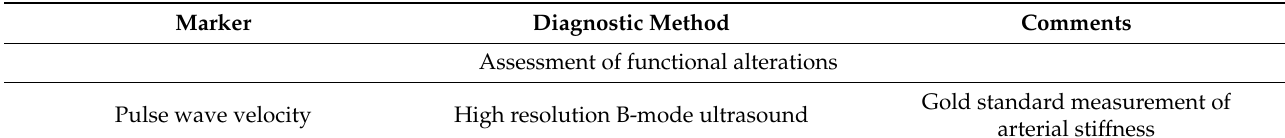
Table 2. Surrogate markers of subclinical atherosclerosis in patients with